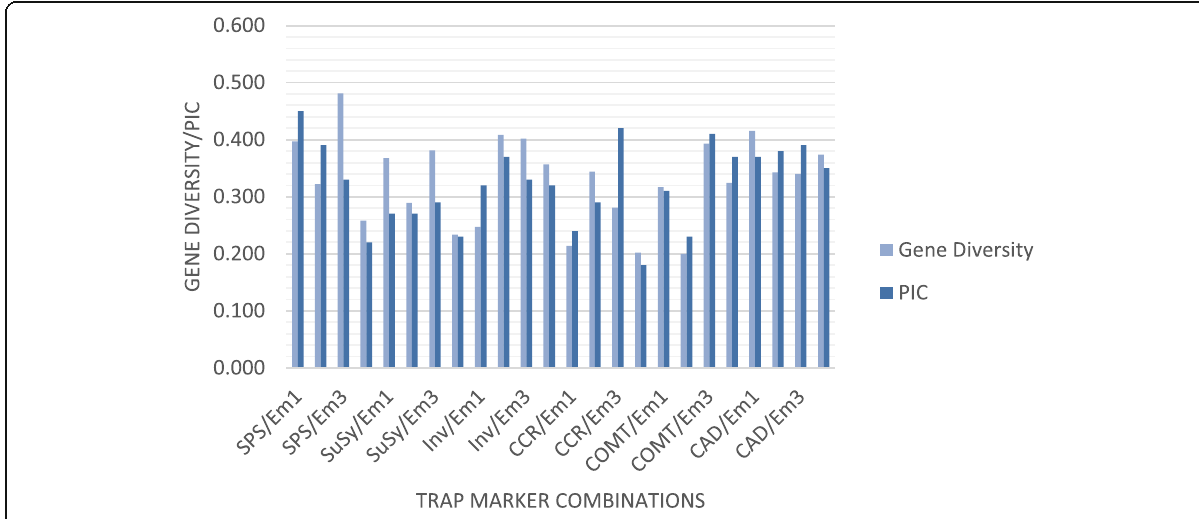
Fig. 4 Gene diversity and polymorphic information content in 30 sweet sorghum genotypes